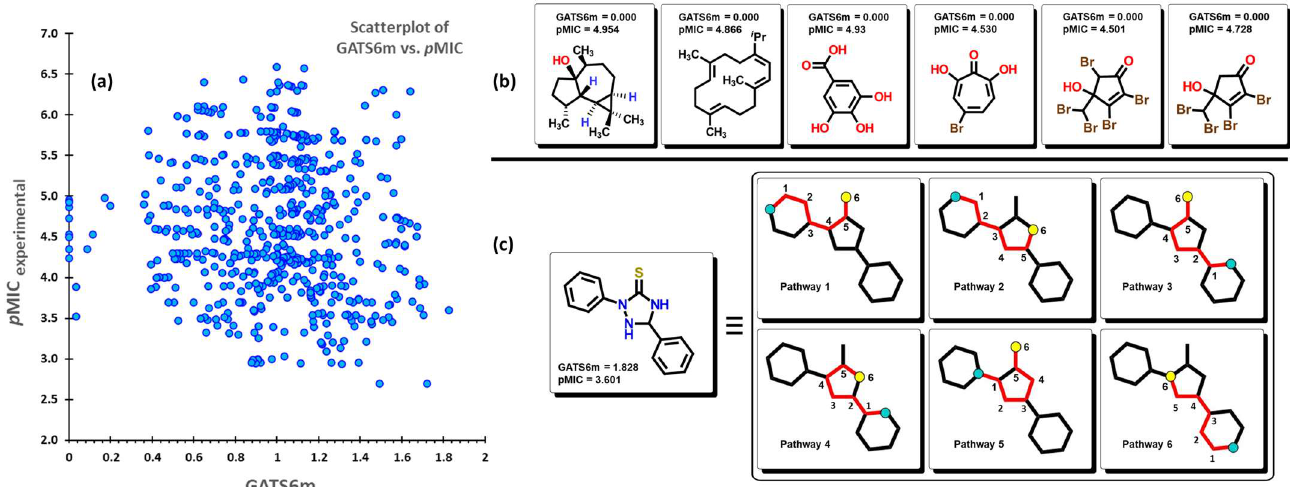
Figure 8. ( a ) Scatterplot of the GATS6m descriptor vs. the experimental p MIC value of the 592 molecules. ( b ) Molecular structures of compounds with zero value of GATS6m. ( c ) Selected pathways are used for the calculation of the descriptor.